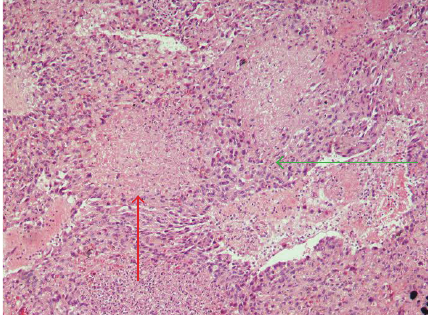
Figure 1: Macroscopic view of the enlarged spleen, nodular appear- ance (arrow).